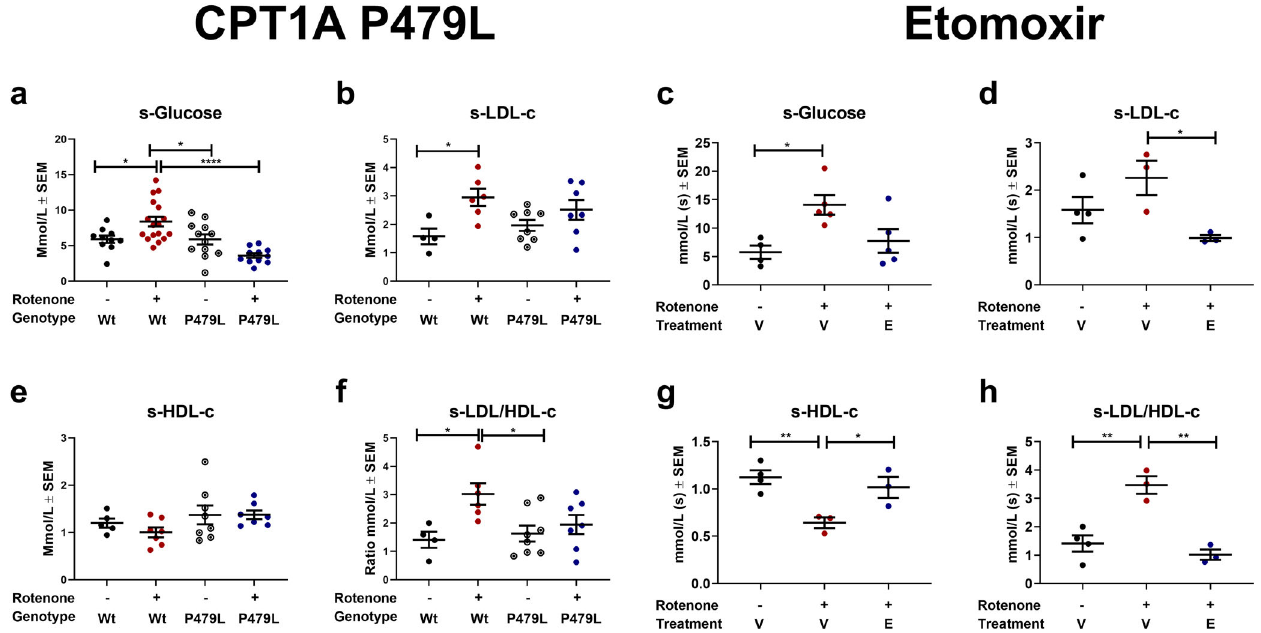
Fig. 2 CPT1A P479L mutation and pharmacological CPT1 inhibition ameliorate rotenone-induced hyperglycemia and lipoprotein disturbances in mice. a Mean serum glucose levels measured in mmol/l ( n = 10 – 17). b Mean serum LDL-c levels measured in mmol/l ( n = 4 – 8). c Mean serum glucose levels measured in mmol/l ( n = 4 – 5). d Mean serum LDL-c levels measured in mmol/l ( n = 3 – 4). e Mean serum HDL-c levels measured in mmol/l ( n = 5 – 8). f Mean ratio of serum LDL-c/HDL-c levels ( n = 4 – 8). g Mean serum HDL-c levels measured in mmol/ l ( n = 3 – 4). h Mean ratio of serum LDL-c/HDL-c levels ( n = 3 – 4). Signi fi cant differences for serum experiments: * p ≤ 0.05; ** p ≤ 0.01. Wt wildtype, P479L Cpt1a P479L homozygote genotype, E etomoxir, R rotenone, V Vehicle. Center line = mean, and whiskers = standard error of the